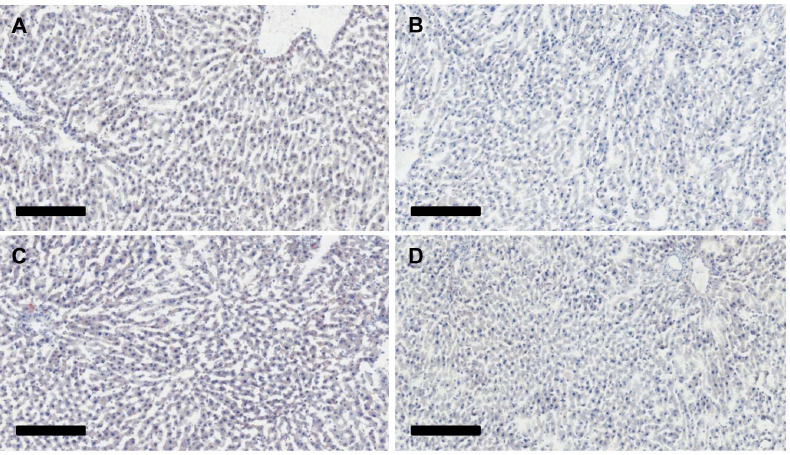
Fig. 1. Histological analysis of livers. Liver sections were stained using Oil Red O and Harris hematoxylin. ( A ) and ( B ) Representative images of H 2 O animal livers. ( C ) and ( D ) Representative images of EtOH livers. There is no evidence of hepatic steatosis in the livers of EtOH animals following 23 weeks of ethanol exposure. The scale bar is 200 m m.